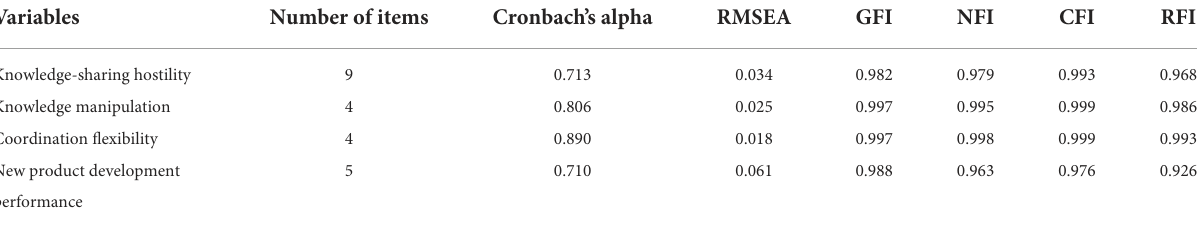
TABLE 3 Descriptive statistics and correlation analysis of the variables.